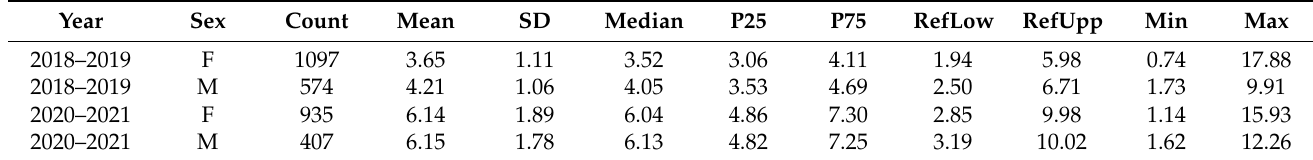
Table 12. Combined glucose reference intervals for gender, partitioned per